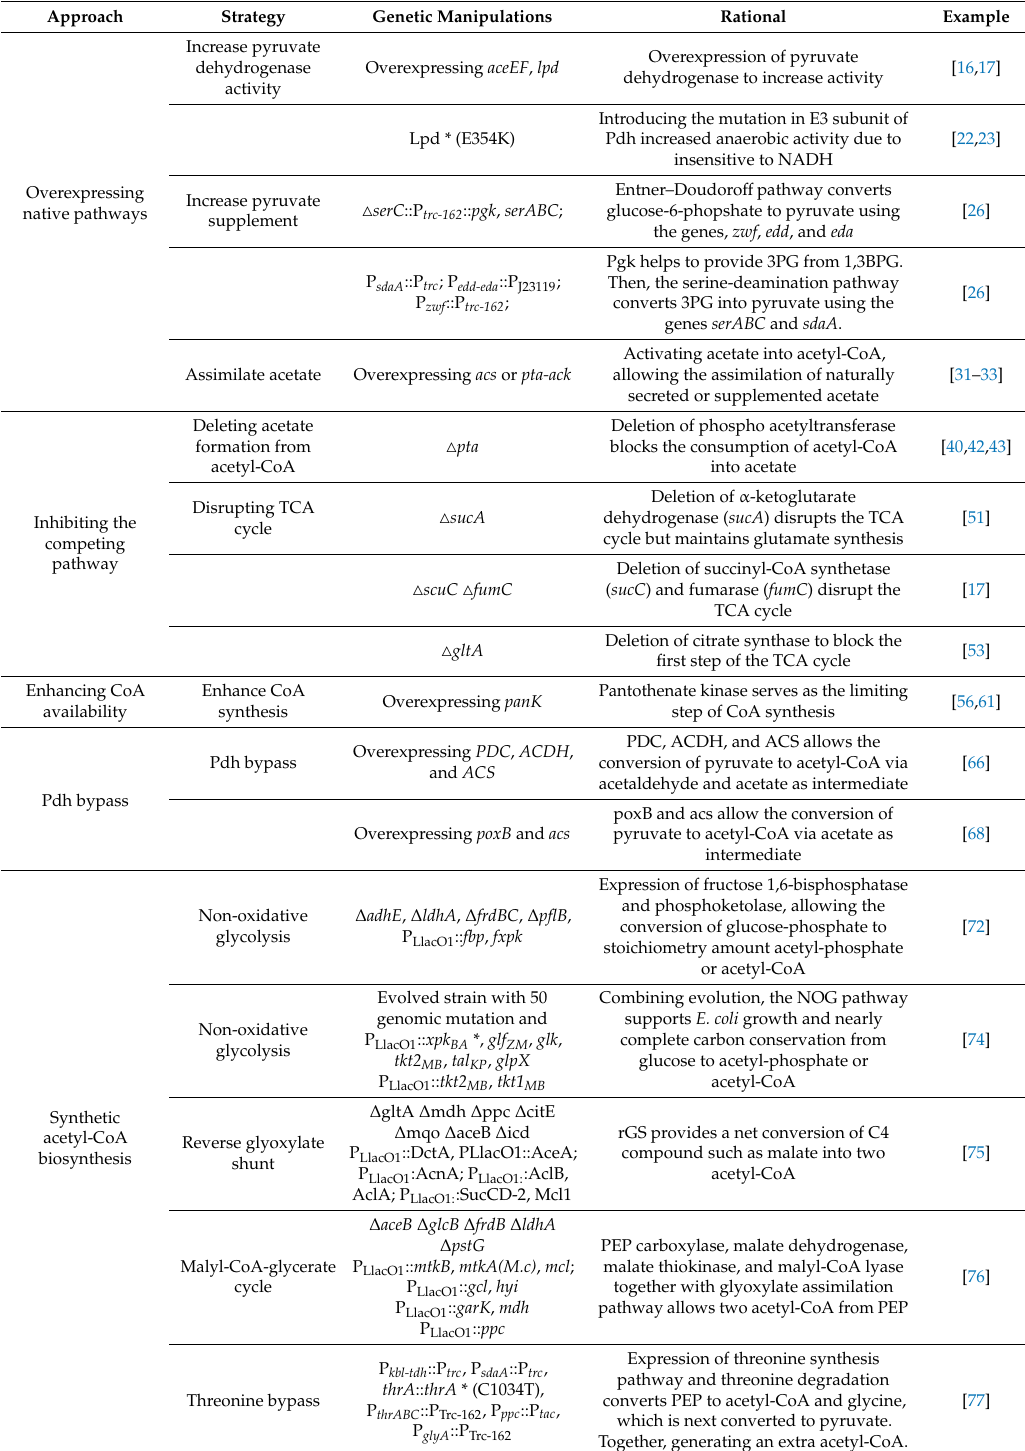
Table 1. Strategies for increasing acetyl-CoA and acetyl-CoA based